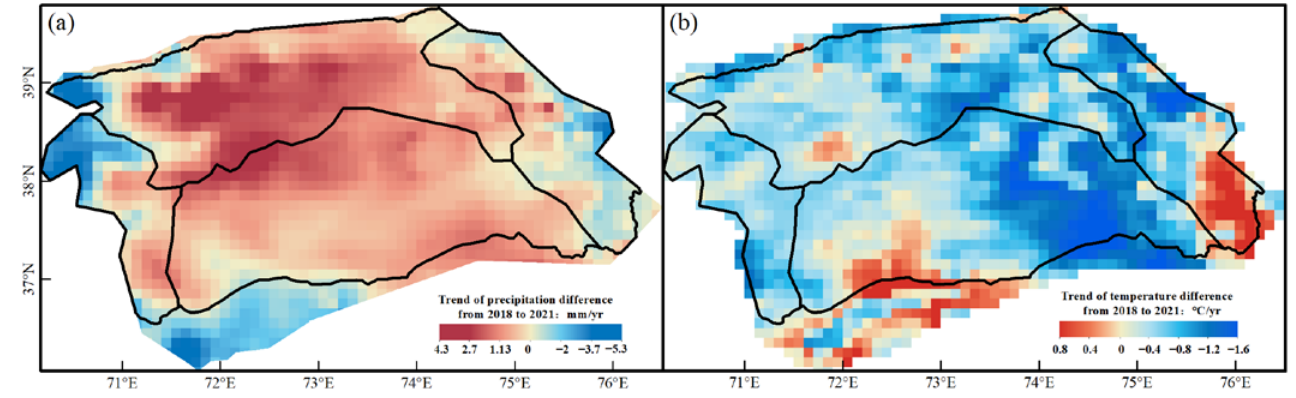
Figure 11. Spatial variations in ( a ) yearly precipitation (mm/yr) and ( b ) yearly temperature (°C/yr) in the Pamir from winter 2018 to 2021.